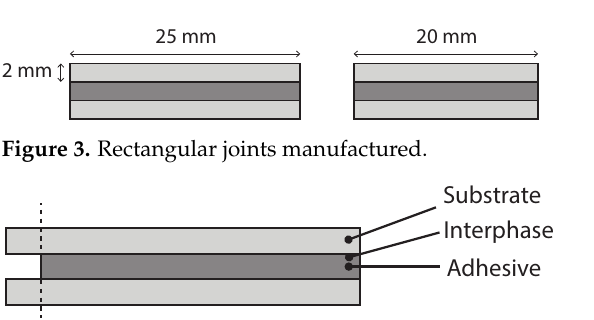
Figure 4. Trim RJs to ensure the adhesive is in the same plane of the end of the substrate for every side.